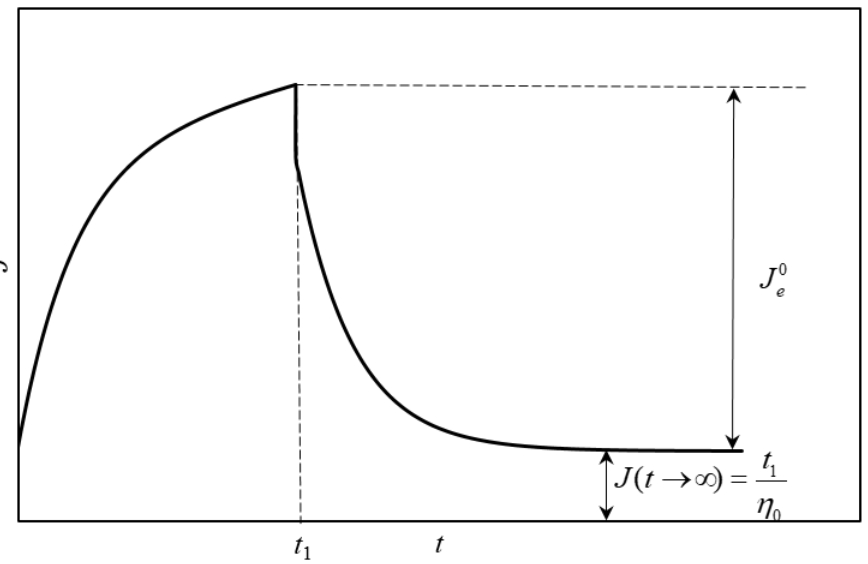
Figure 1. Relationship between equilibrium compliance ( J e 0 ) and zero-shear viscosity ( η 0 ) and the values obtained from a creep-recovery test.